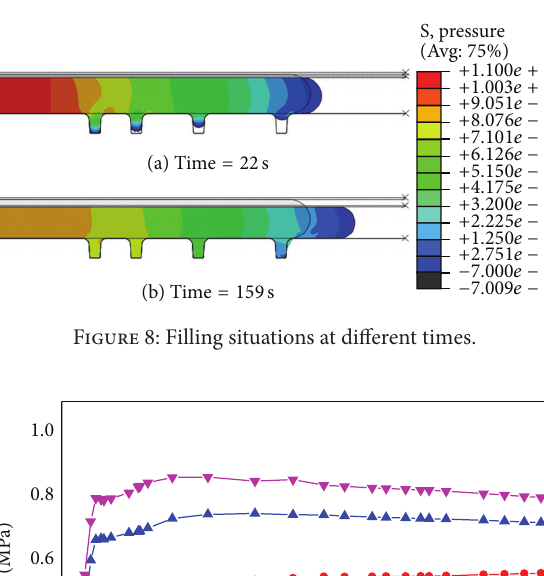
Figure 10: Filling depth-time curves of four grooves.